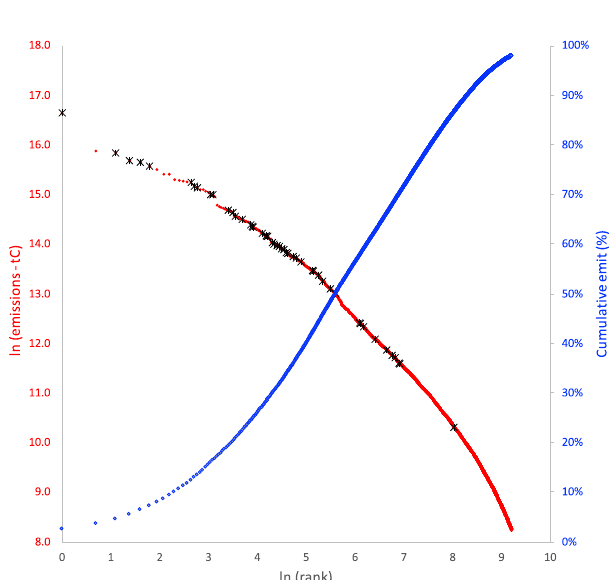
Fig. 4 Rank distribution (red) and cumulative emissions (blue) of US city FFCO 2 emissions. The sample of 48 cities included in this study are denoted with black “ X ” within the rank distribution. City FFCO 2 emissions are from the Vulcan v3.0 results within US Census Designated Places. The sample of 48 cities used for comparison represents 13.7% of 2015 US urban FFCO 2 emissions and 17.7% of the 2015 US urban population. Of these 48, 28 cities are within the top 100 urban emitters in the USA (see Source data for additional details).